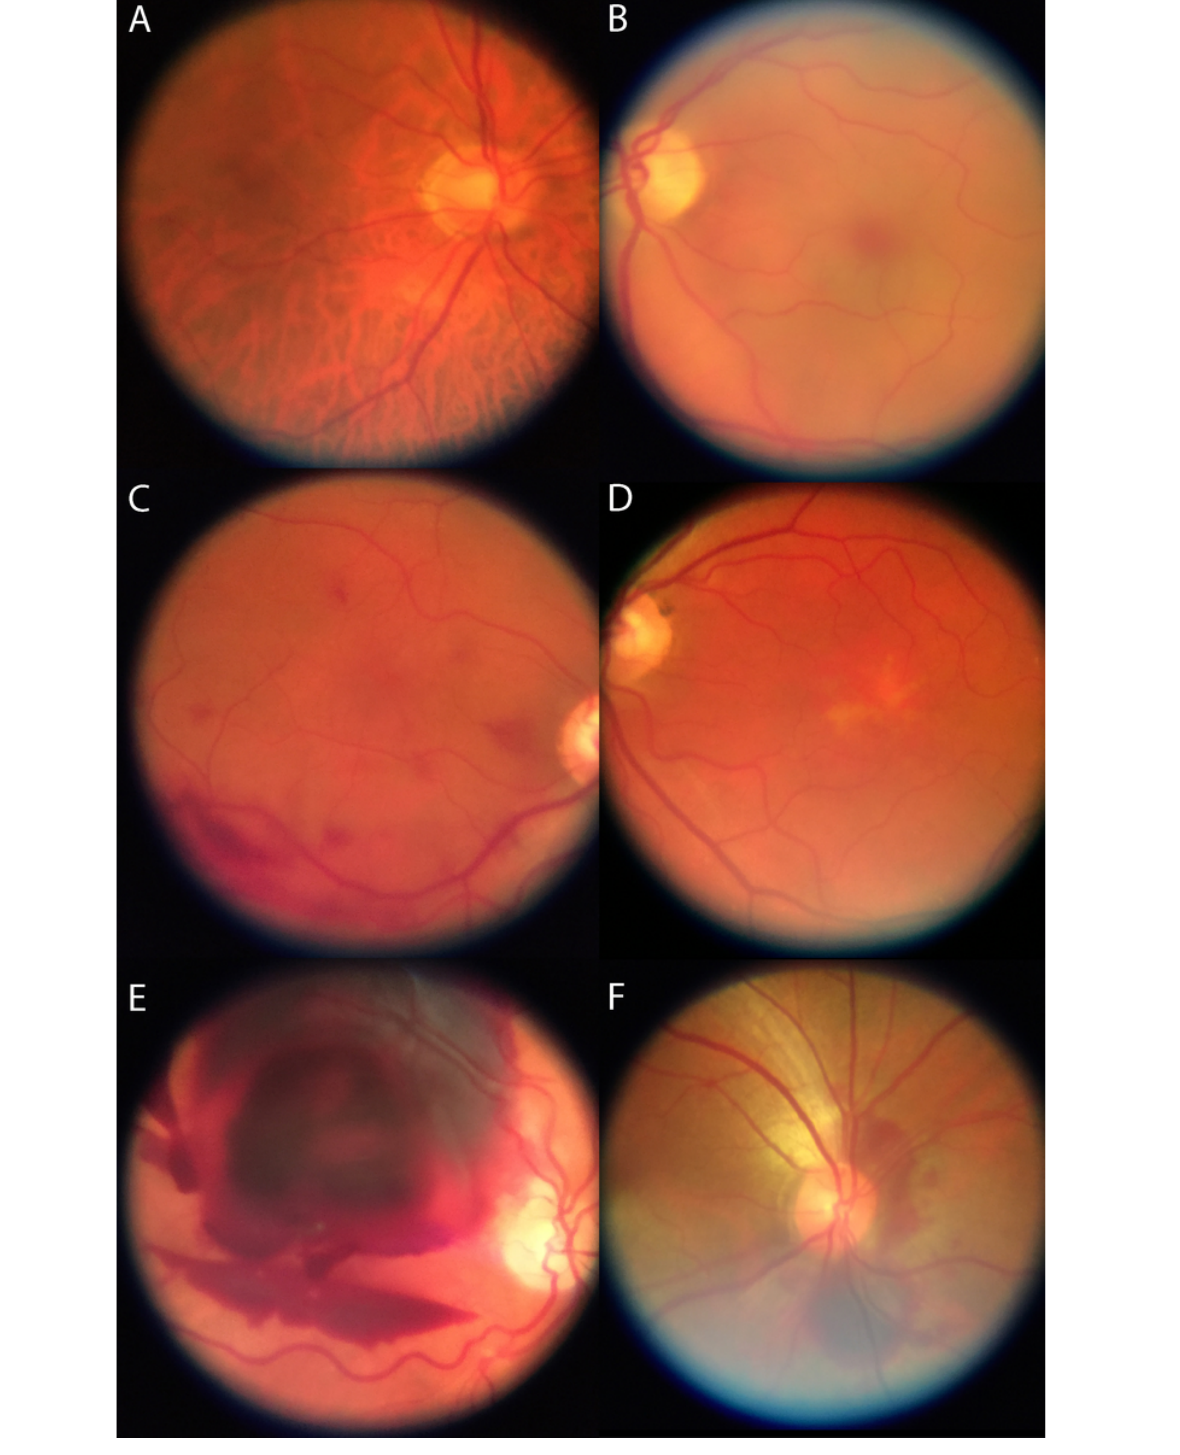
Figure 2. Exemplary smartphone-based fundus images of the posterior pole. (A) Healthy eye with slight peripapillary atrophy, (B) central retinal artery occlusion with a cherry red spot, (C) multifocal preretinal subhyaloidal hemorrhage, (D) adult vitelliform macular dystrophy, (E) massive subretinal combined with subhyaloidal hemorrhage, and (F) traumatic peripapillary choroidal